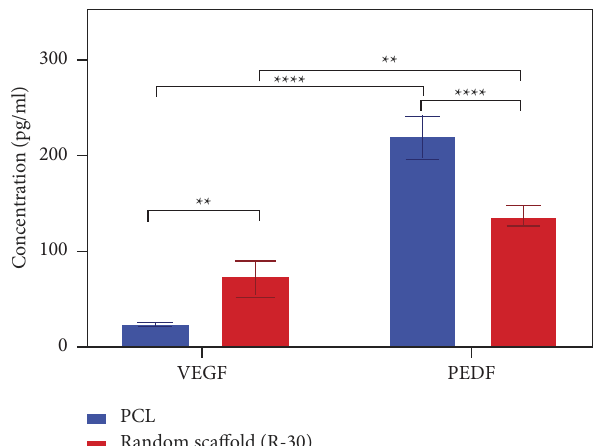
Figure 11: ELISA analyses of the VEGF and PEDF secretion of the ARPE-19 cells grown on the R-30 and PCL scafolds for 1